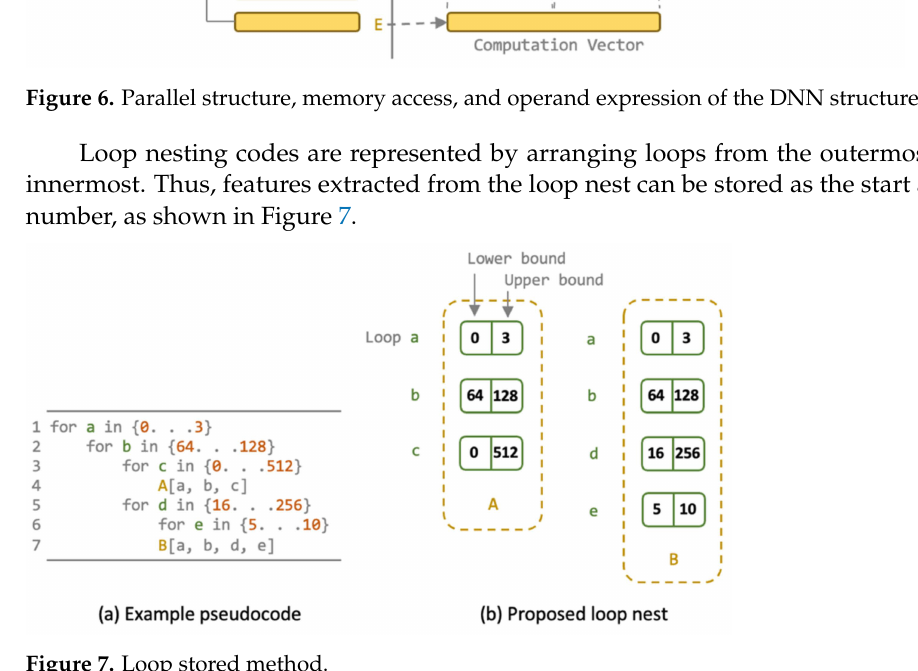
Figure 7. Loop stored method.